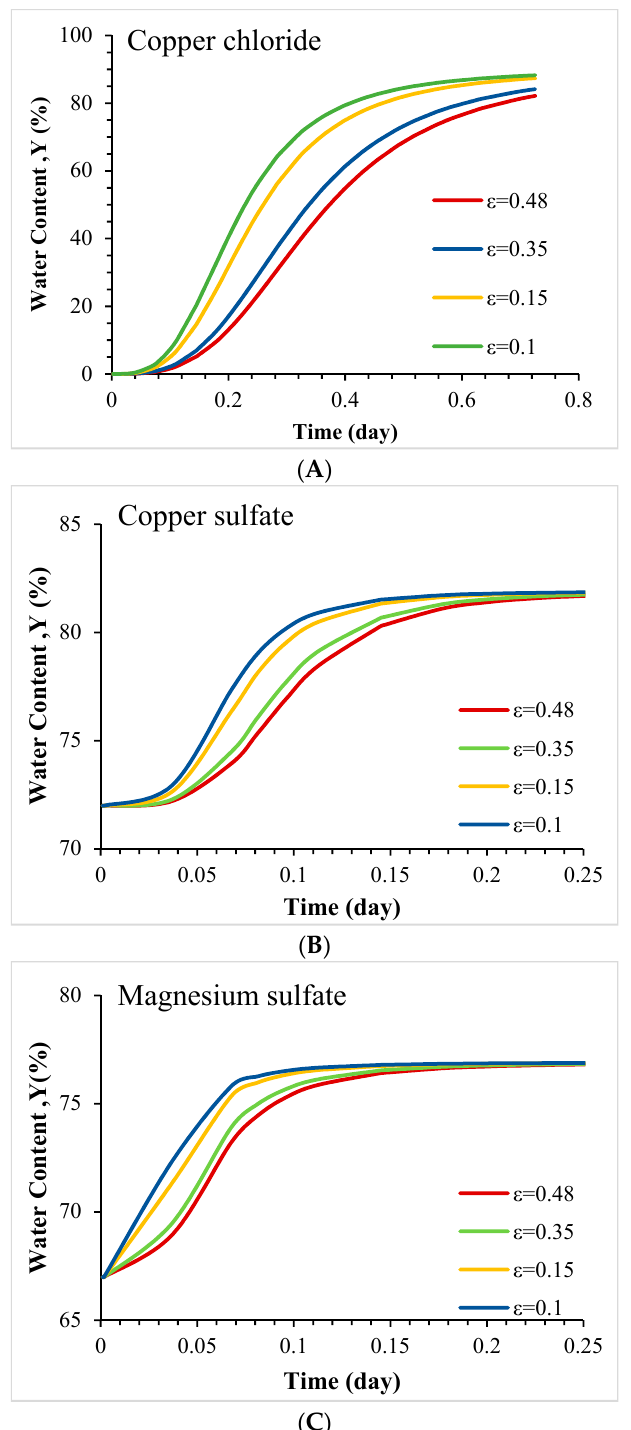
Figure 5. Water content curves of the three salts: ( A ) copper chloride, ( B ) copper sulfate, and ( C ) magnesium sulfate under different porosities, 𝜀 .